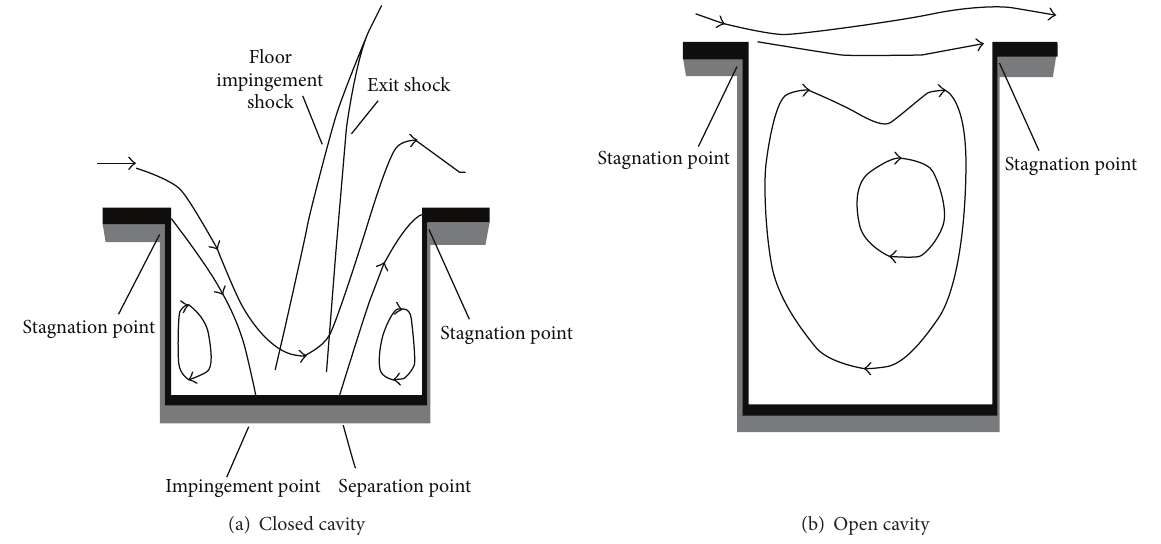
Figure 1: Supersonic cavity flow: (a) closed cavity, (b) open